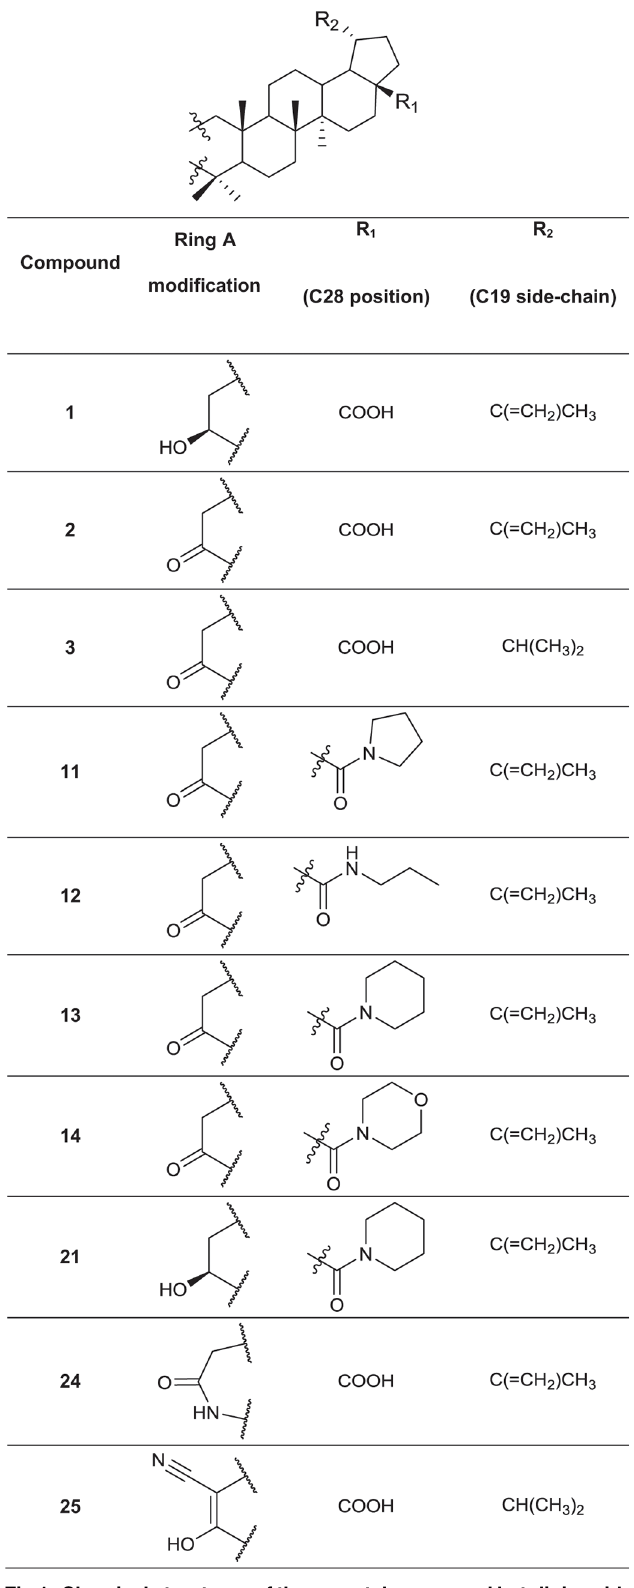
Fig 1. Chemical structures of the parental compound betulinic acid and its derivatives.